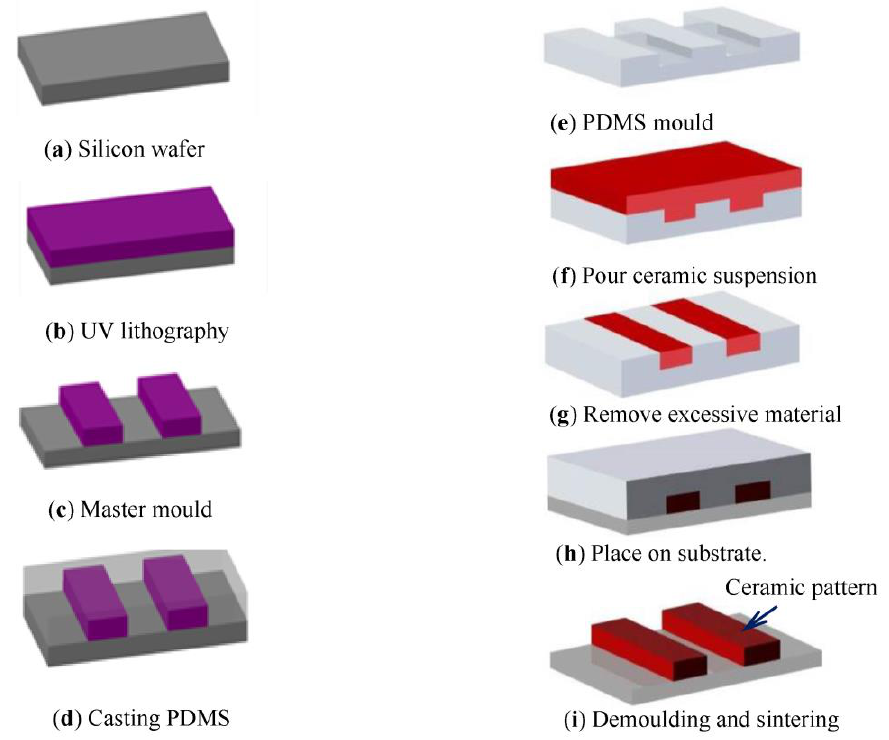
Figure 1. A schematic diagram of the manufacturing process.